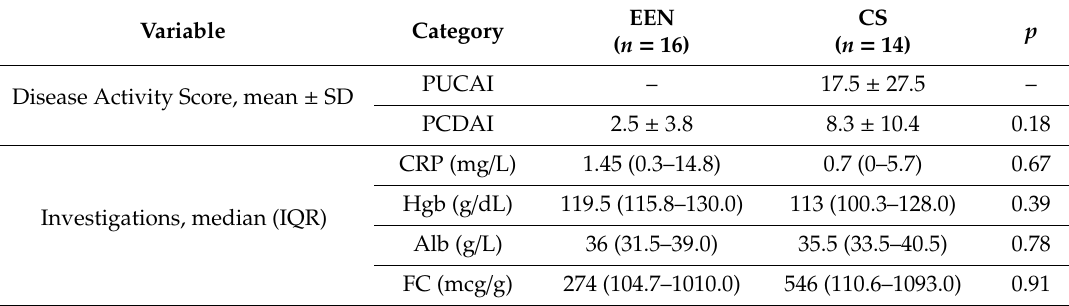
Table 2. End of treatment characteristics of patients receiving EEN or